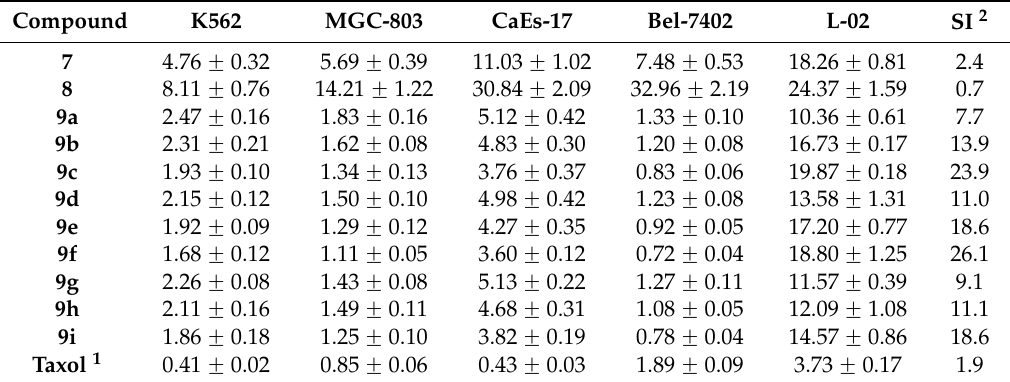
Table 2. Antiproliferative activity of the synthesized compounds (IC 50 µ